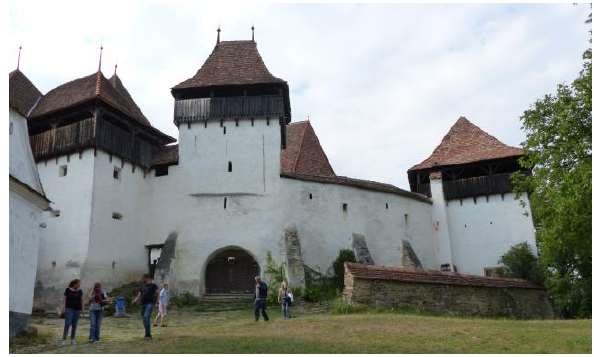
Figure 7. Viscri fortified church.